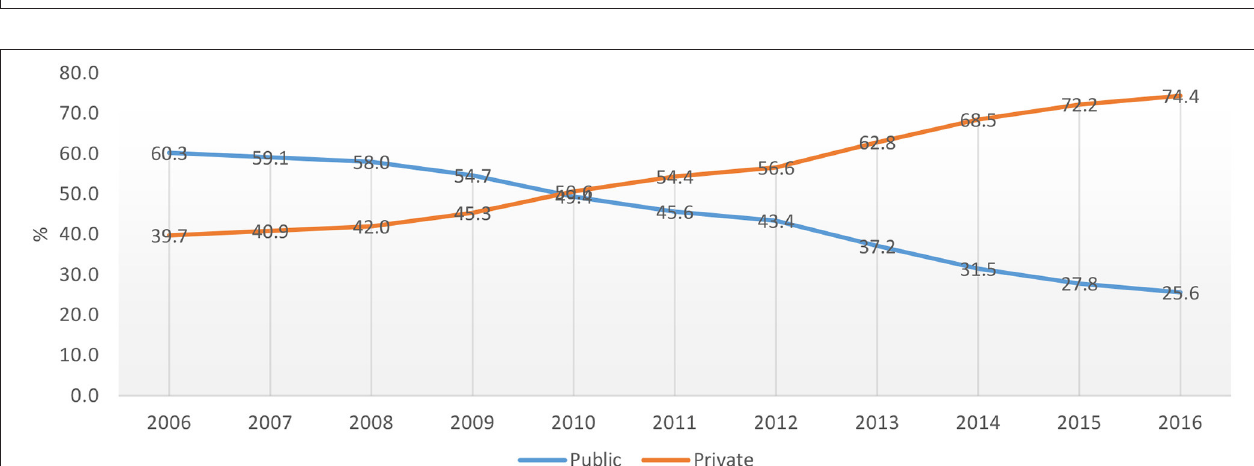
FIGURE 3 | Trends in gross generation and net consumption of electricity in Turkey Source: TURKSTAT 13 .